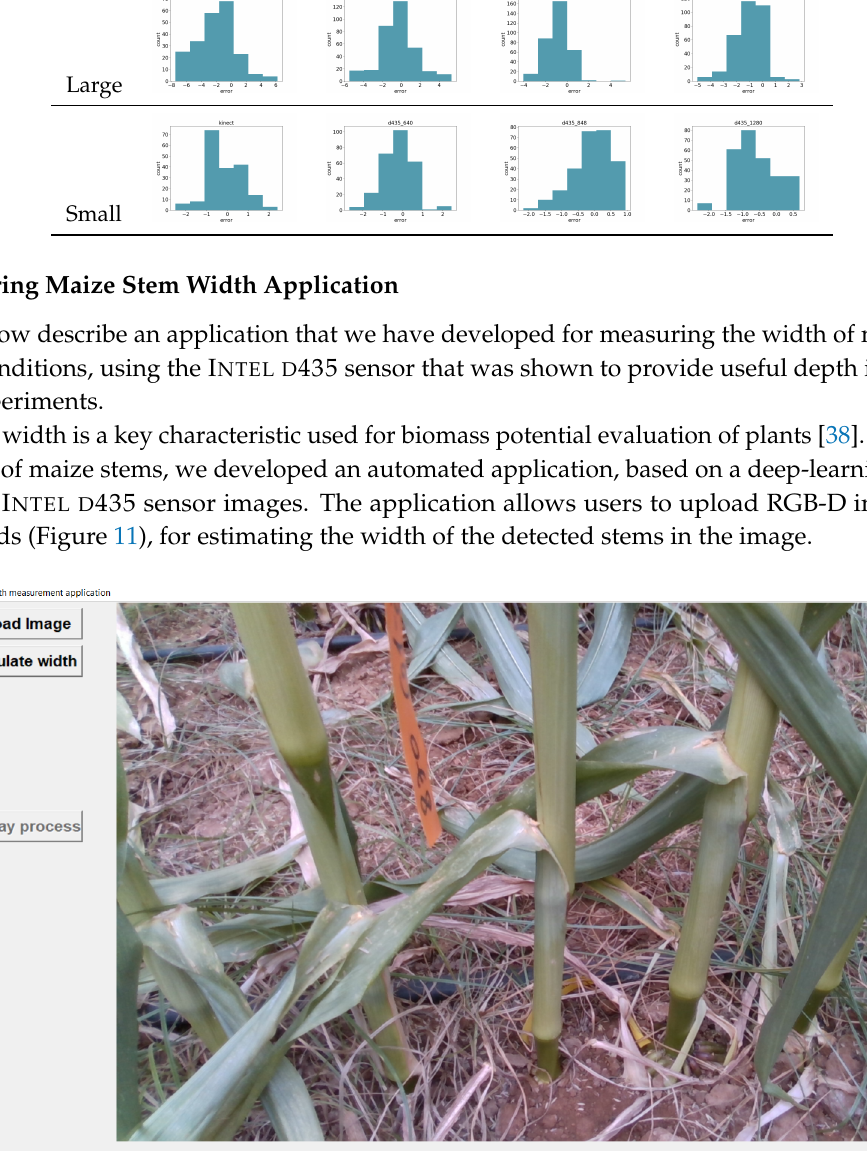
Figure 11. Screenshot of the maize stem width application. Showing an image of maize stems in a field, uploaded for width